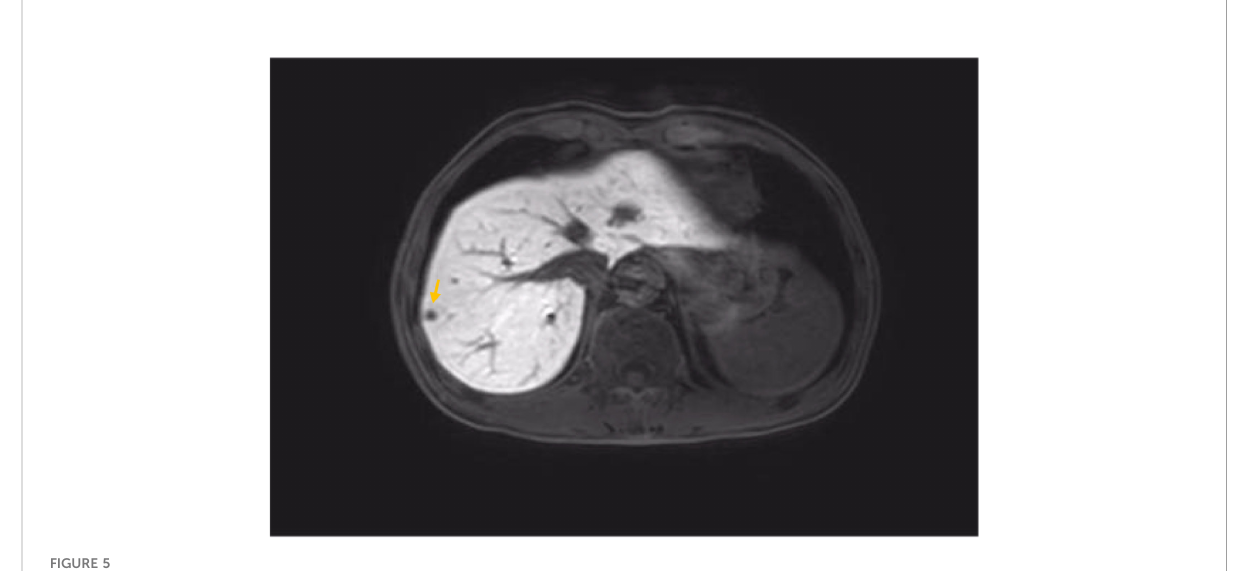
FIGURE 5 MRI fi ndings 6 months after surgery (liver metastasis).